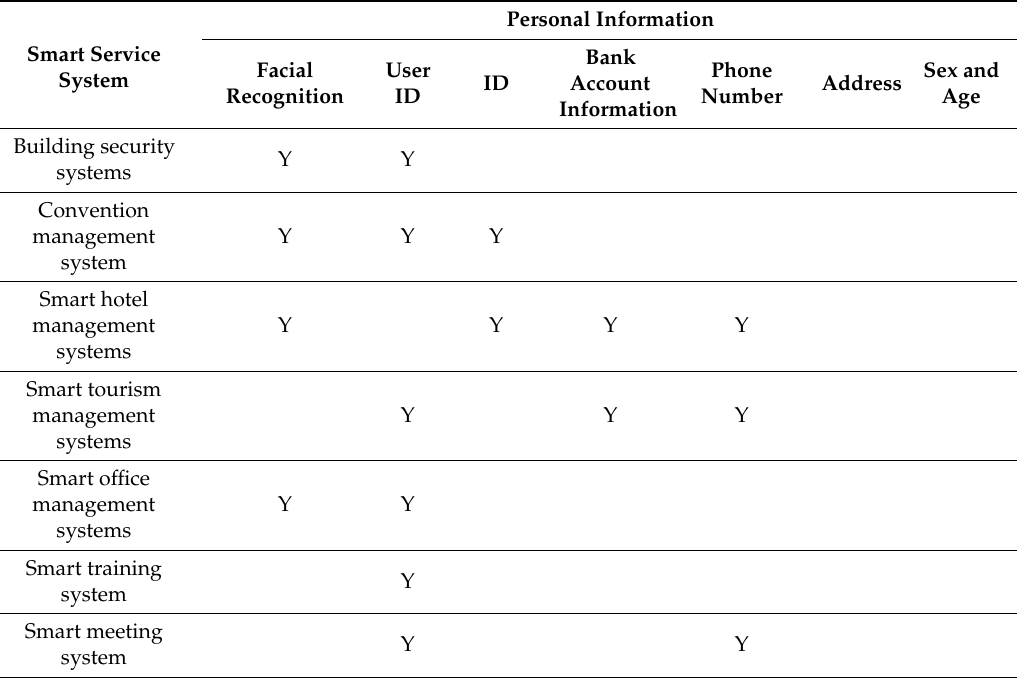
Table 1. Personal information in the smart service system (SSS) proposed on Huangguan Island.